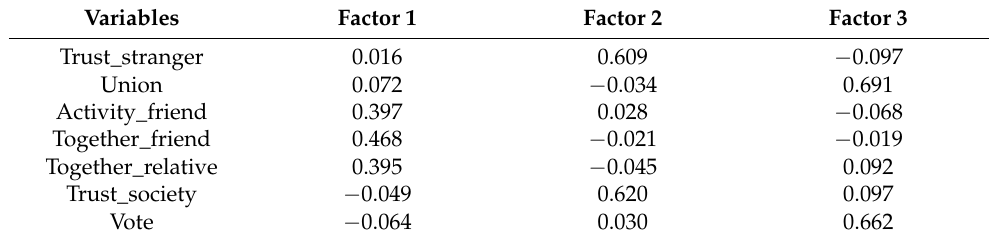
Table A6. Factor Score Coefficient Matrix (2).